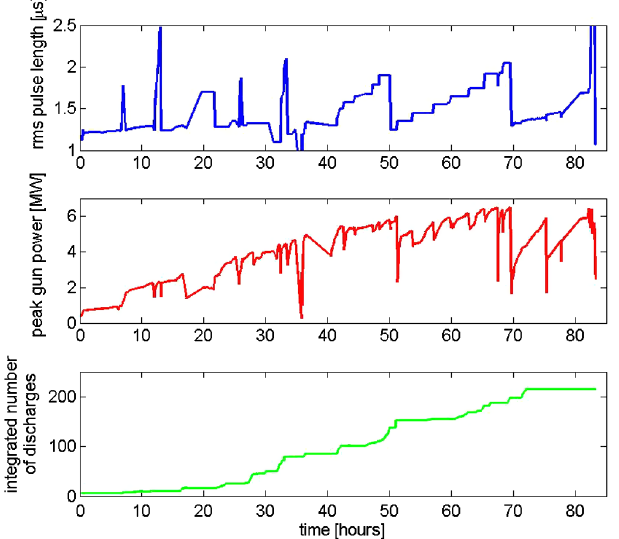
FIG. 13. Progress in power (measured from the gun probe), rms pulse length and integrated number of discharges during conditioning.